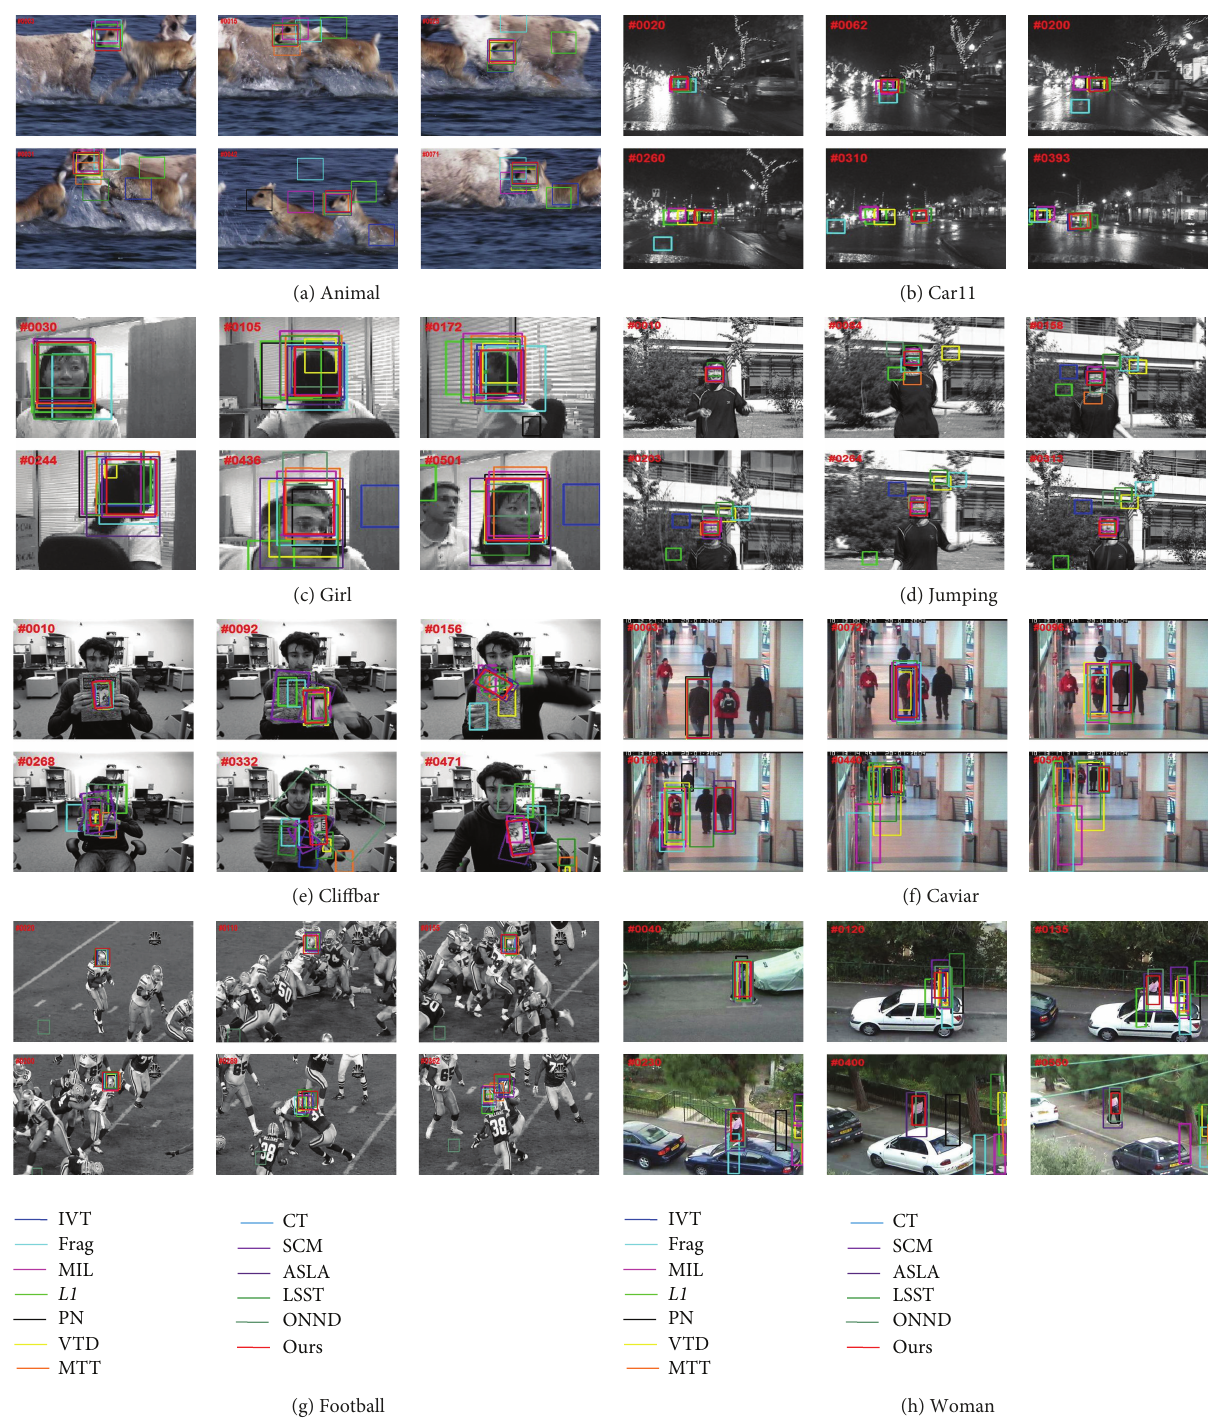
Figure 3: Comparison of 13 trackers on 8 video sequences in terms of bounding box reported.